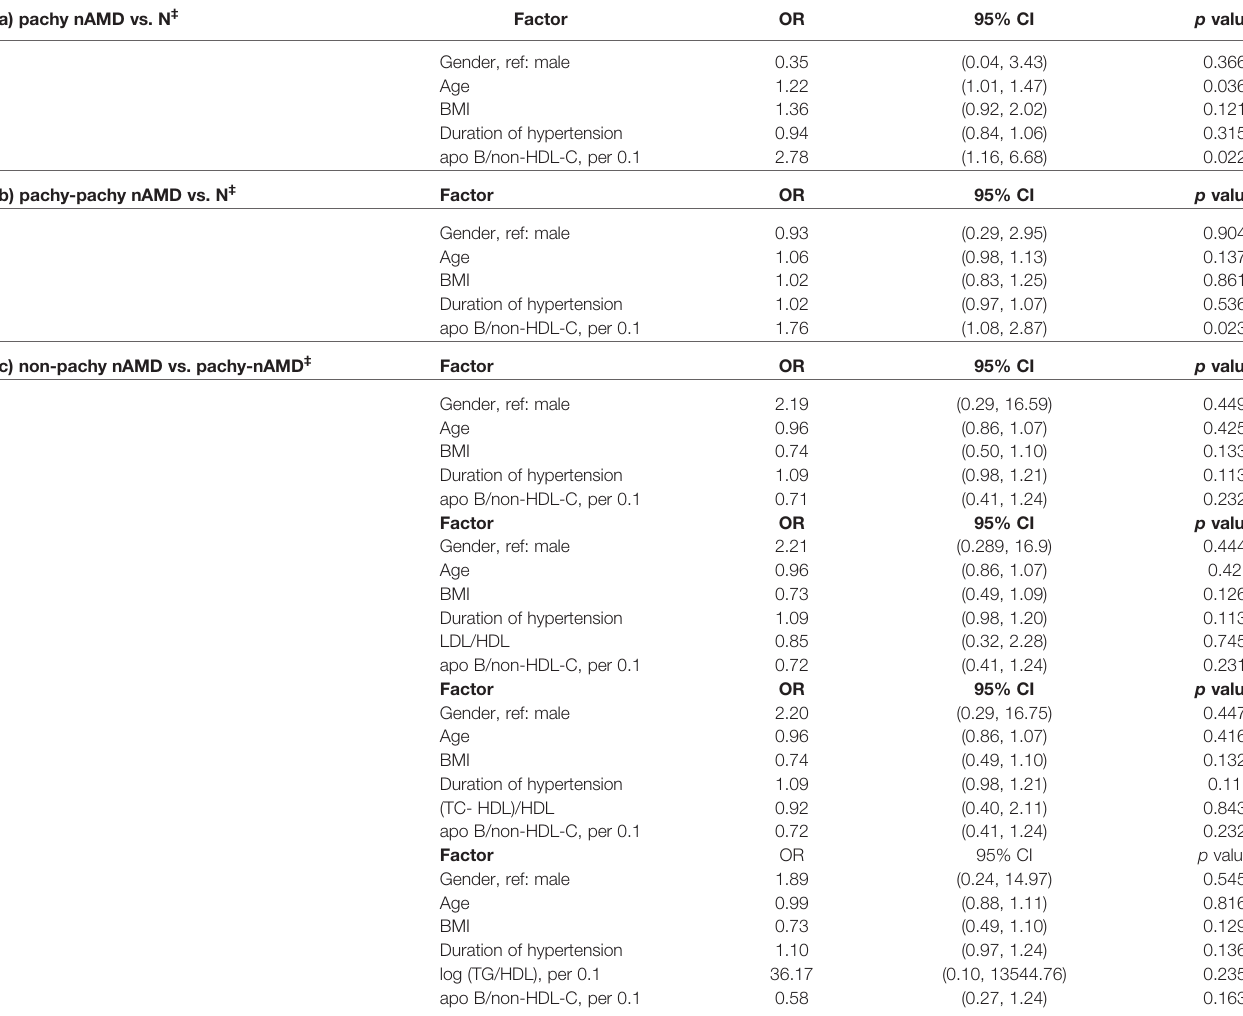
TABLE 7 | Comparisons in the lipid pro fi les and apolipoproteins between the subgroups of nAMD (pachy- and nonpachy-) and control by multivariable logistic regression analysis. (a) pachy nAMD vs. N